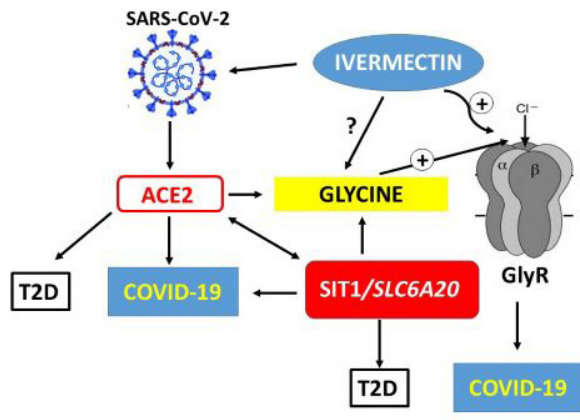
Figure 2: Schematic representation of a potential role of SLC6A20 protein product SIT1 in regulation of glycine levels as well as in treatment of COVID-19 and Type 2 diabetes (T2D). The interaction of SIT1 with the ACE2 receptor for SARS-CoV-2 (6) as well as with the risk and traits of T2D (38) were proposed; The SIT1 transporter is involved in the transport of amino acids, including glycine (3), which appears to have beneficial effects against the proinflammatory cytokine secretion induced by SARS-CoV-2 infection (53) and in prognosis of T2D (82); Ivermectin, as a partial agonist of glycine- gated chloride channels, was recently suggested to interfere with the COVID-19 cytokine storm by inducing the activation of glycine receptors (GlyR)